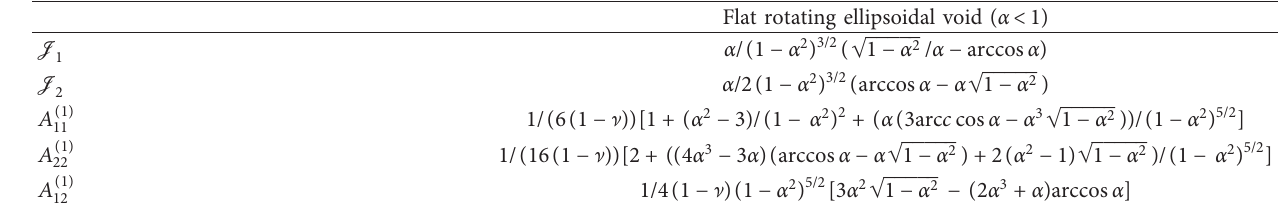
Table 9: Components for flat rotating ellipsoidal